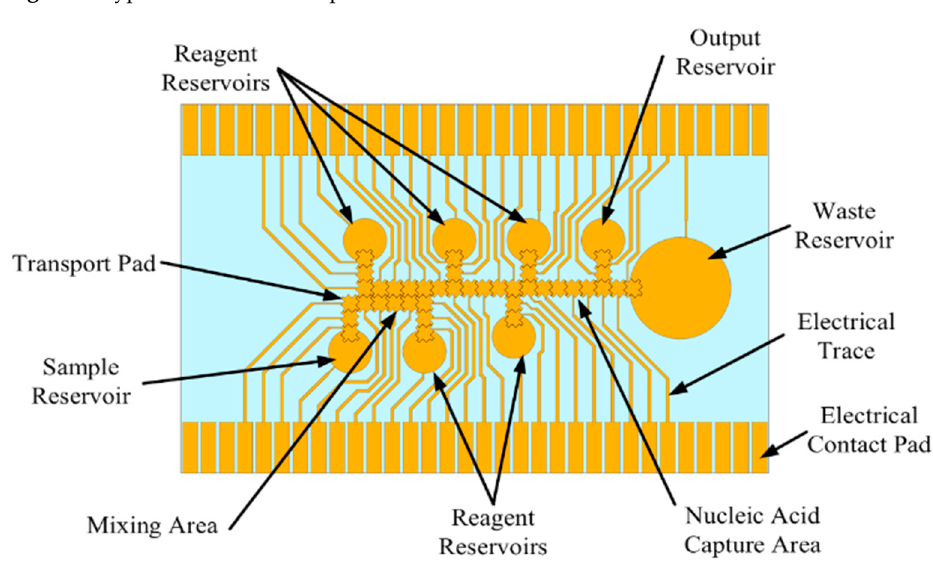
Figure 3. Nucleic acid extraction chip design .